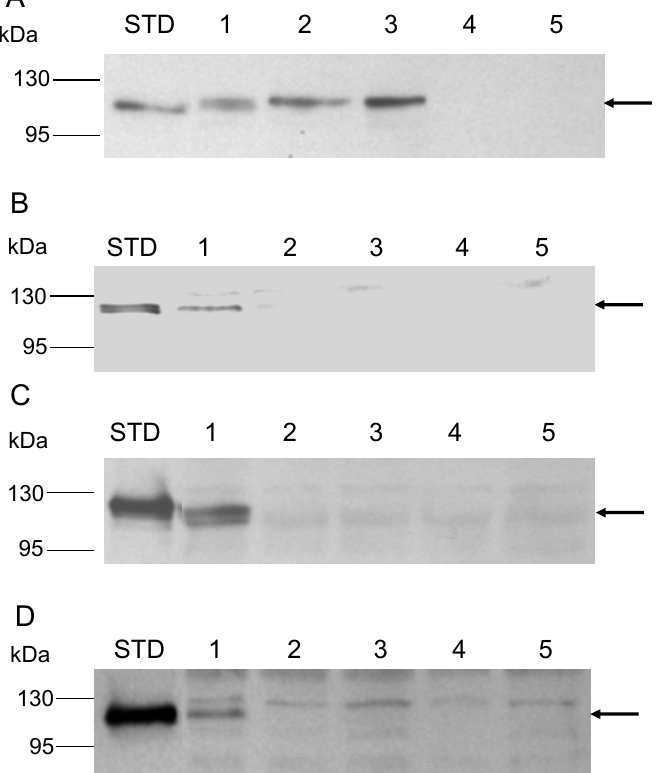
Figure 6. Western blot analysis of supernatant and sub-cellular fractions. Panel A , culture supernatants. Panel B , cytoplasmic fractions. Panel C , membrane fractions. Panel D , S-layer fractions. Lanes were; STD (purified AmyA), 1 ( malA p- amyA , PBL2058), 2 (Gly877Stop mutant, PBL2059), 3 (Lys898Stop mutant, PBL2065), 4 ( N -terminal deletion mutant, PBL2064), 5 ( amyA :: lacS disruption mutant, PBL2004). Supernatant samples were derived from culture volumes proportional to 1 × 10 9